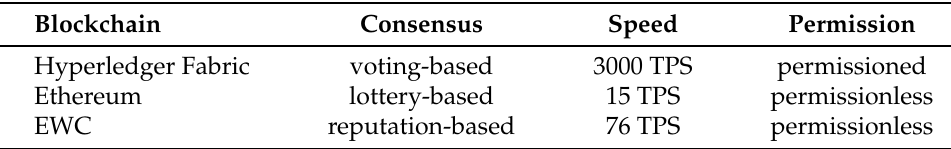
Table 1. Qualitative comparison of various blockchain